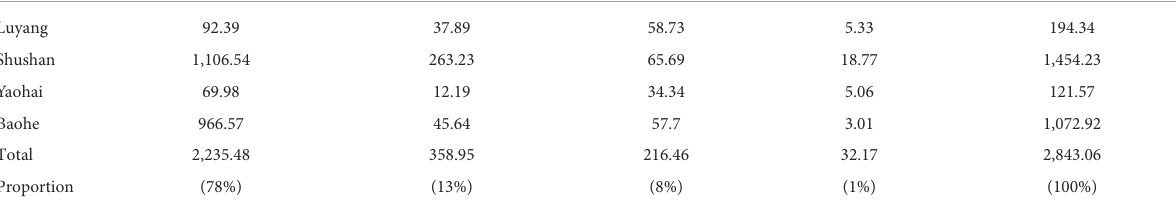
TABLE 2 Summary of UGS in the central urban area of Hefei. District